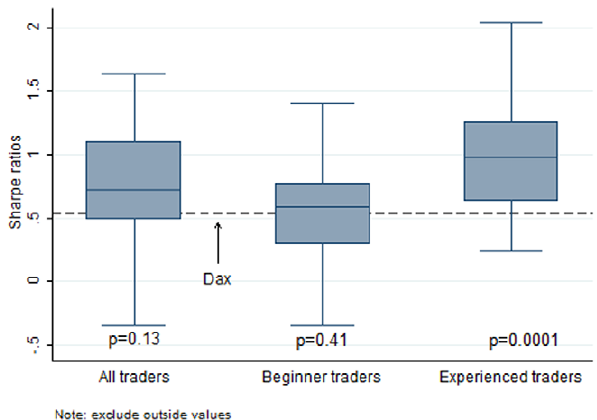
Figure 2. Trader Sharpe Ratios compared to Dax. Box plot showing the distribution of Sharpe Ratios for all traders compared to Sharpe Ratio of the Dax (the German Stock Index); beginner traders only (2 yrs or less); and experienced traders only. T-test p-values indicated below each plot. The Dax Sharpe Ratio over the period is represented as a dashed